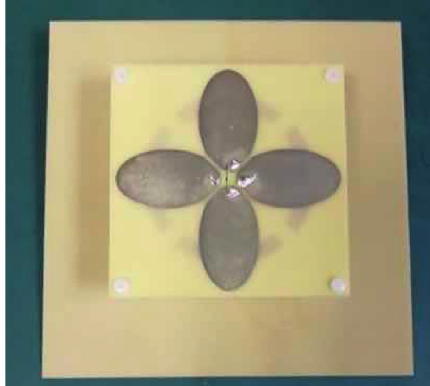
Figure 6: Photograph of the antenna prototype.